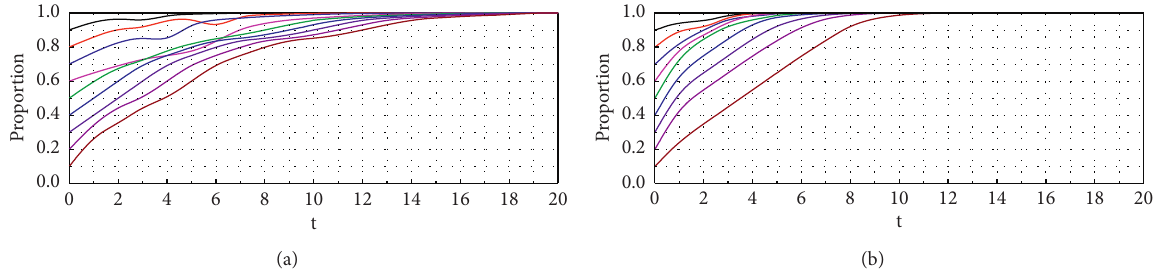
Figure 3: (a) Proportion of evolution strategy. (b) Proportion of evolution strategy shared by community governance.